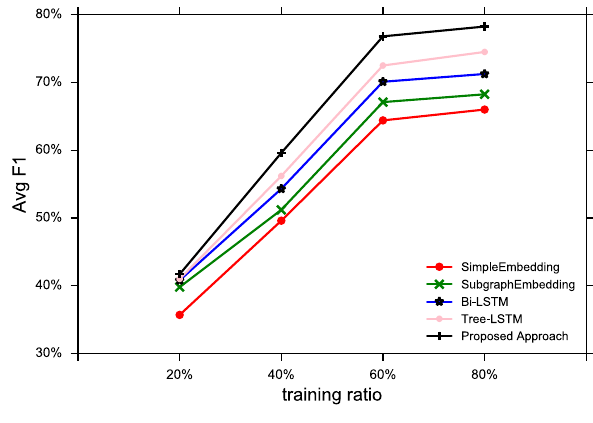
Fig. 7 QA result on